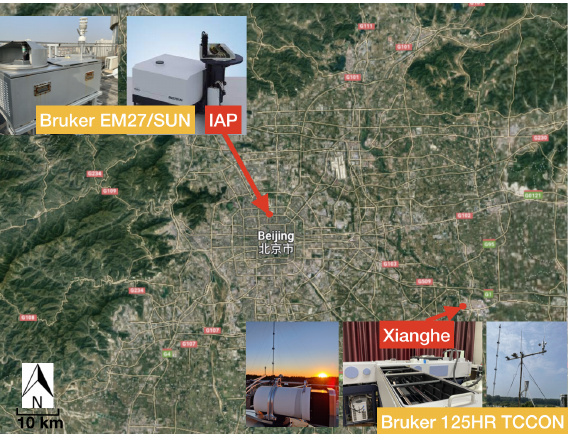
Figure 1. The location of the Bruker EM27/SUN measurements in Beijing (urban) and the Bruker IFS 125HR measurements in Xianghe (suburb). The background map is from Google Maps with the name (English and Chinese) of Beijing remarked (https://www.google.com/maps, accessed on 30 June